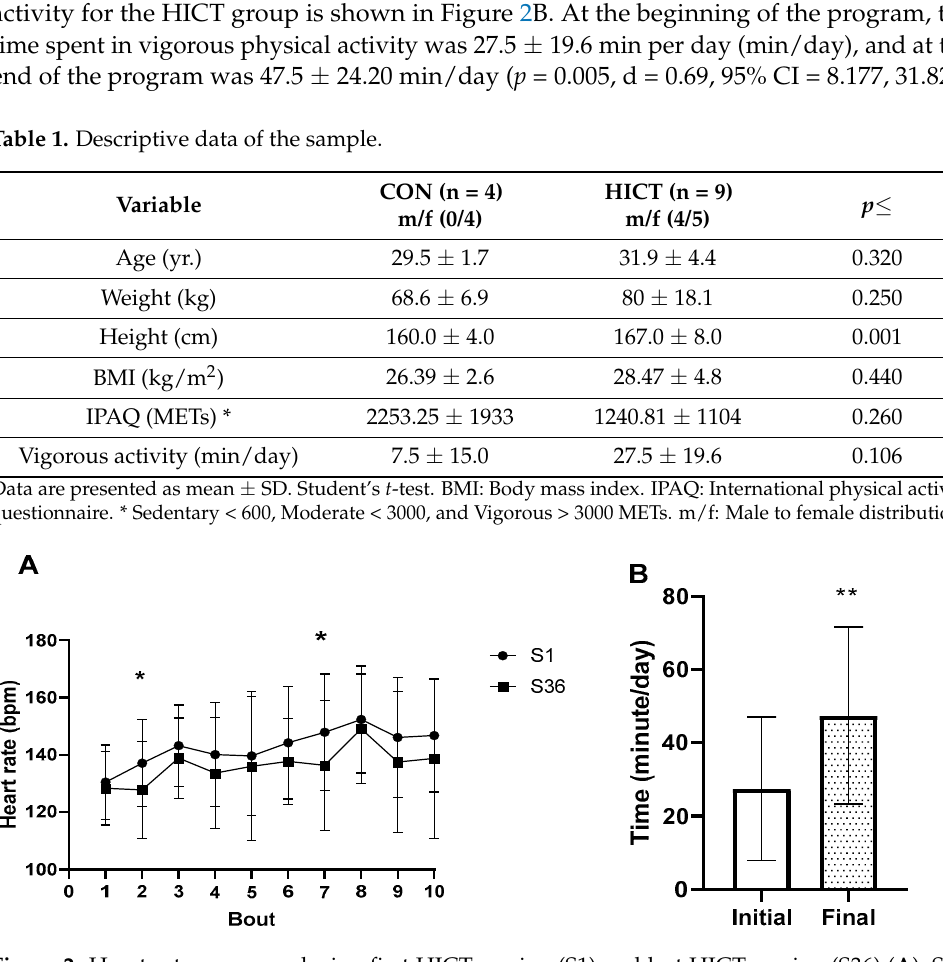
Table 1. Descriptive data of the sample.